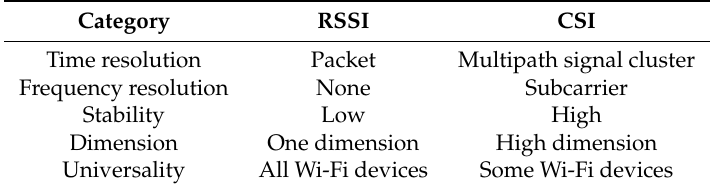
Table 1. The differences between Received Signal Strength Indicator (RSSI) and Channel State Information (CSI).